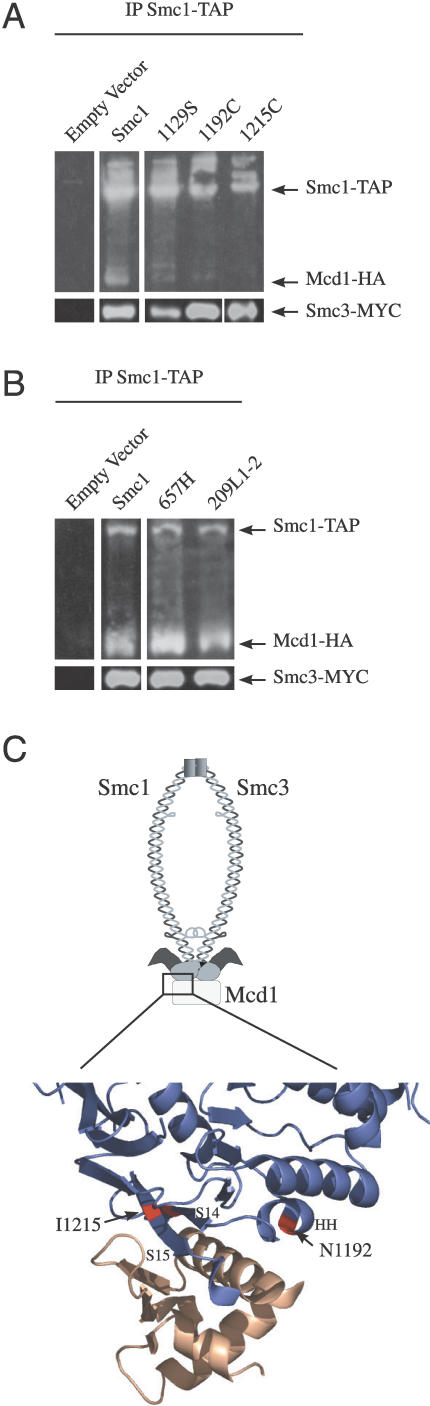
A Subset of SMC1 RID Alleles Disrupt Cohesin Complex AssemblyProtein extracts were prepared from the strain 1377 A1-4B (MCD1-6HA) or 2258G (SMC3-12MYC) containing minichromosomes with the indicated SMC1 alleles. Cells were grown under repressing conditions to assure physiological levels of the different Smc1 proteins. Smc1 proteins were immunoprecipitated and separated by SDS-PAGE. Immunoblots were probed to detect Smc1-TAP, Mcd1-6HA, and Smc3-12MYC (see Materials and Methods).(A and B) None of the Smc1 RID alleles disrupt the physical association with Smc3-12MYC. (A) Alleles in the Signature motif, HH Helix, S15 β-strand, and Walker A motif (unpublished data) of Smc1 disrupt the physical association of Mcd1-6HA, whereas (B) alleles in the Hinge and Loop1 regions do not.(C) A region of the cocrystal of Smc1 (blue) and Mcd1 (brown) is shown (PDB 1W1W). Helix HH and the β-sheets S14 and S15 are indicated. The amino acid positions of 1215 and 1192 are indicated (red).